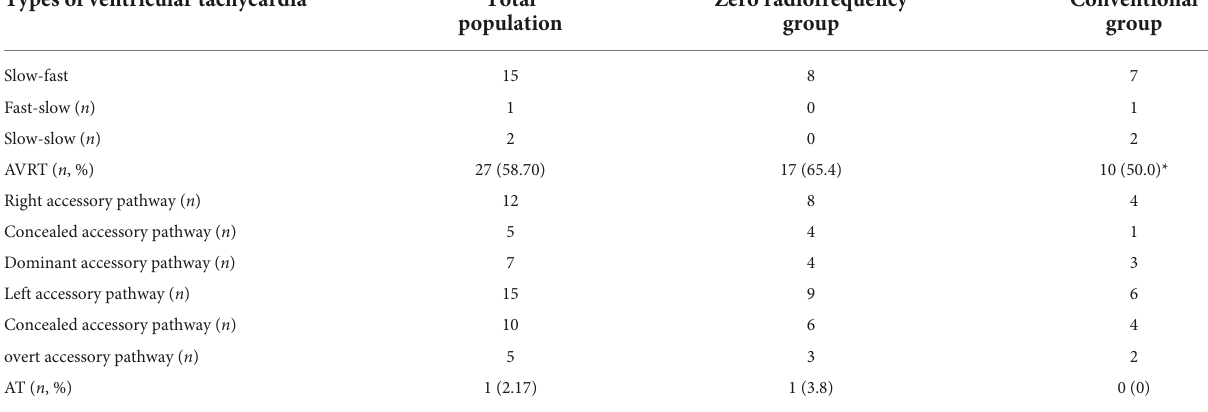
TABLE 2 Types of supraventricular tachycardia.